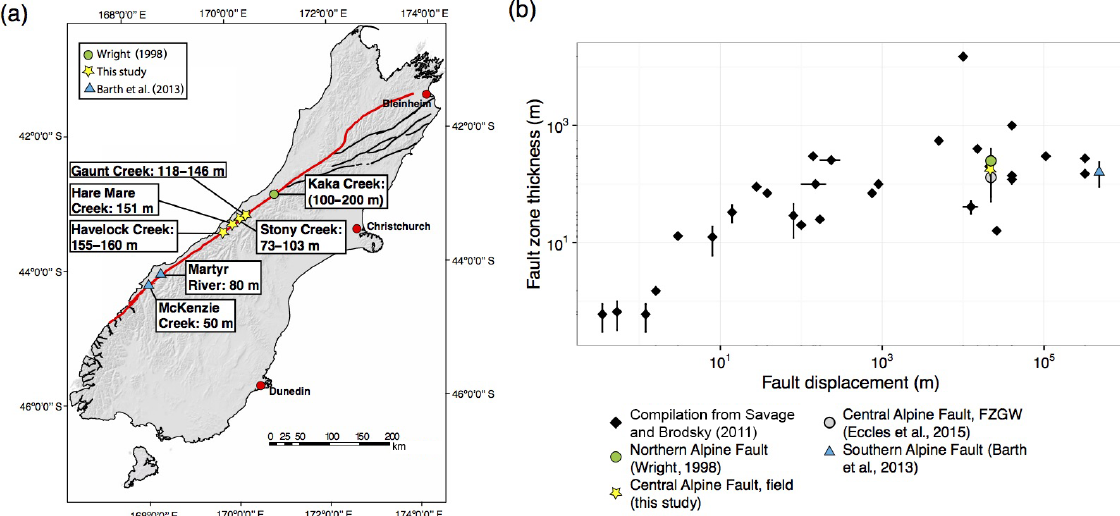
Figure 13. (a) Compilation of estimates of the inner damage zone width on the Pacific Plate side of the Alpine Fault (red line) from four creek sections in this study (Gaunt Creek, Stony Creek, Hare Mare Creek, and Havelock Creek). This is combined with other along-strike estimates of damage zone thickness for the Pacific Plate side of the Alpine Fault: McKenzie Creek and Martyr River (Barth et al., 2013) and Kaka Creek (Wright, 1998). (b) Log–log plot of fault zone thickness as a function of fault displacement previously presented in Savage and Brodsky (2011), combined with estimates made for the Alpine Fault assuming footwall damage is no more extensive than in the hanging wall. Displacement for the Alpine Fault is 480km (Norris and Cooper, 2007; Wellman, 1953). However, convergence along the Alpine Fault’s central section requires that it erodes its own fault rocks so these points are plotted to reflect only the brittle displacement the rocks themselves have accommodated as they are exhumed through the seismogenic zone (22km, Barth et al., 2012). Error bars reflect uncertainty in constraining fault zone width (for example, footwall damage is largely unknown), not necessarily variability in fault zone